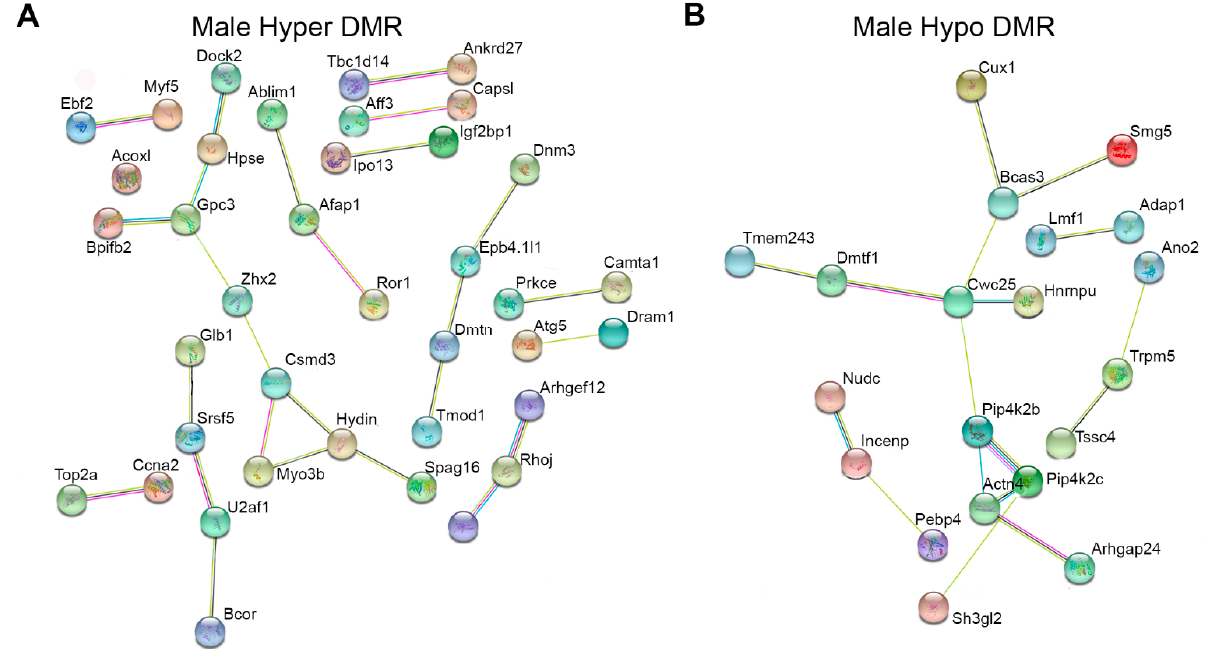
Figure 6. Genes associated with differentially methylated regions (DMRs) in males and females were placed into the STRING network interaction tool. DMR-associated genes in females showed no significant network interactions and are not shown in the figure. Panel ( A ) depicts genes associated with the top 100 most hypermethylated DMRs based on percentage methylation change. Panel ( B ) depicts all hypomethylated DMRs, since there were fewer than 100. To aid in visualization, only the genes that showed significant network interactivity are shown.